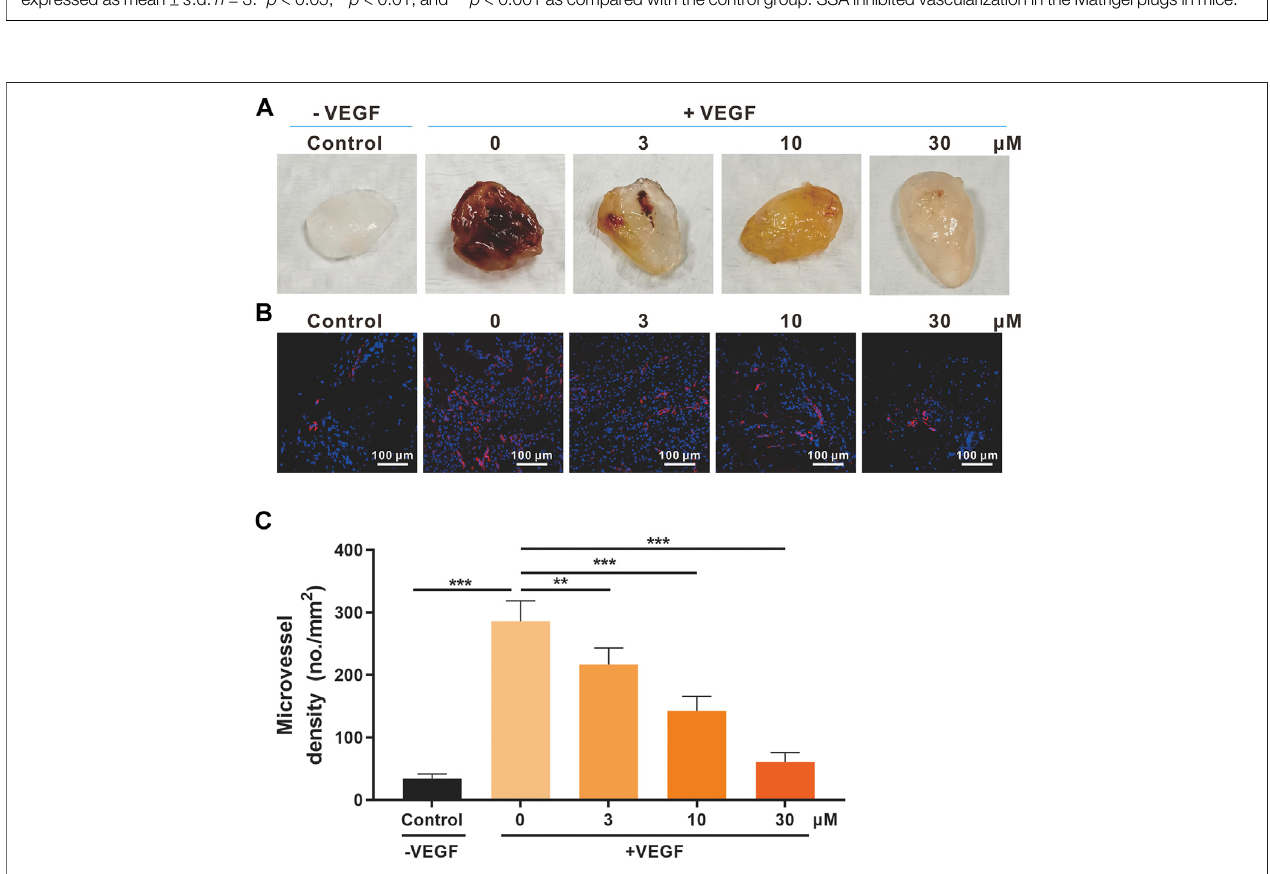
FIGURE 4 | Effects of SSA on in vivo angiogenesis evaluated in the Matrigel plug model. (A) Photographs of the Matrigel plugs of different groups on day 12. (B) Immuno fl uorescence staining of CD31-positive microvessels (red) in the Matrigel plugs. Representative images were shown. (C) Quanti fi ed microvessel density (MVD). All values were shown as mean ± s .d. n (cid:1) 5. ** p < 0.01 and *** p < 0.001. SSA inhibited angiogenesis and growth of orthotopic 4T1 tumors in mice.